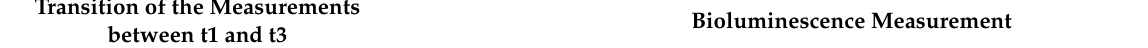
Table 4. Distribution of visual caries codes cross-tabulated with transition toward active or inactive lesions between baseline visit (t1) and